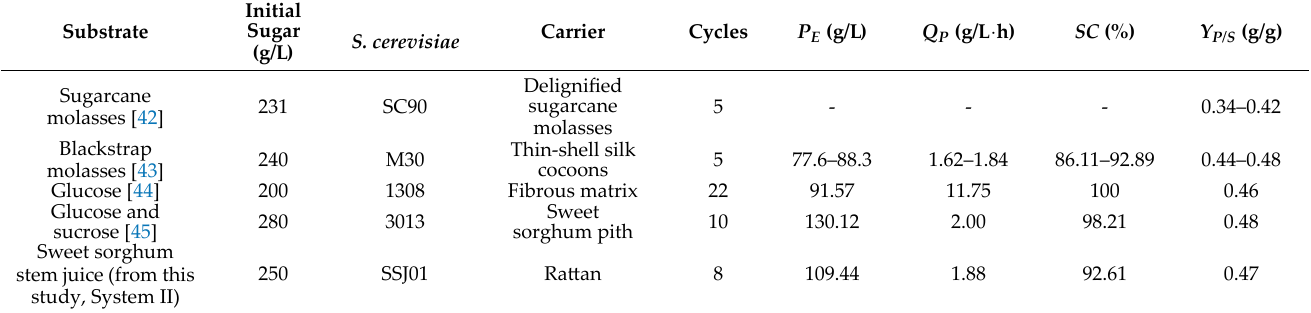
Table 3. Repeated‑batch ethanol fermentation with immobilized S. cerevisiae on various